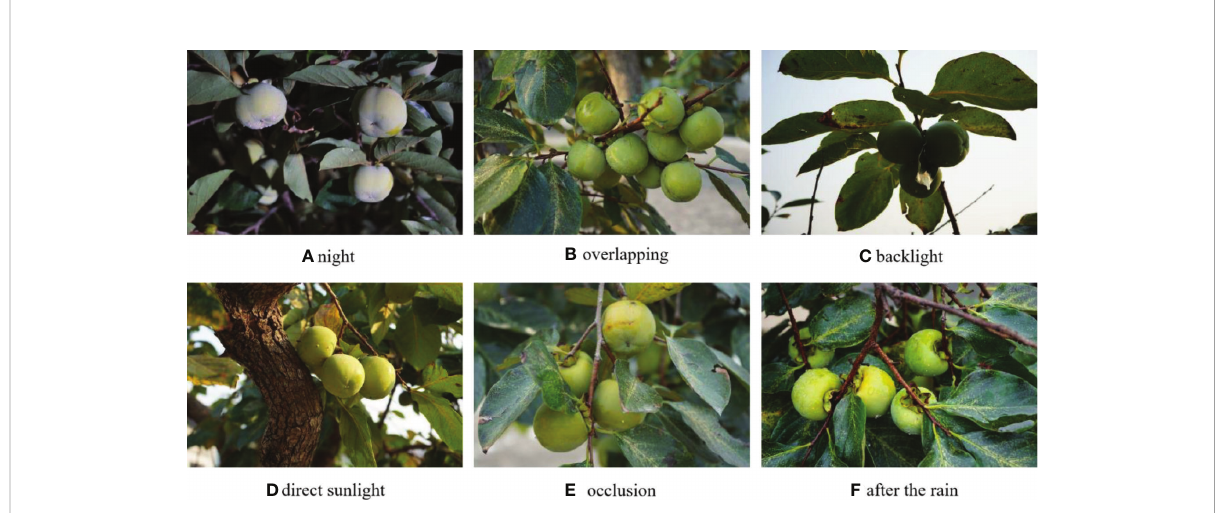
FIGURE 1 Images of green target fruits of persimmon under different environments ( (A-F) are listed for green fruits at various angles and under different